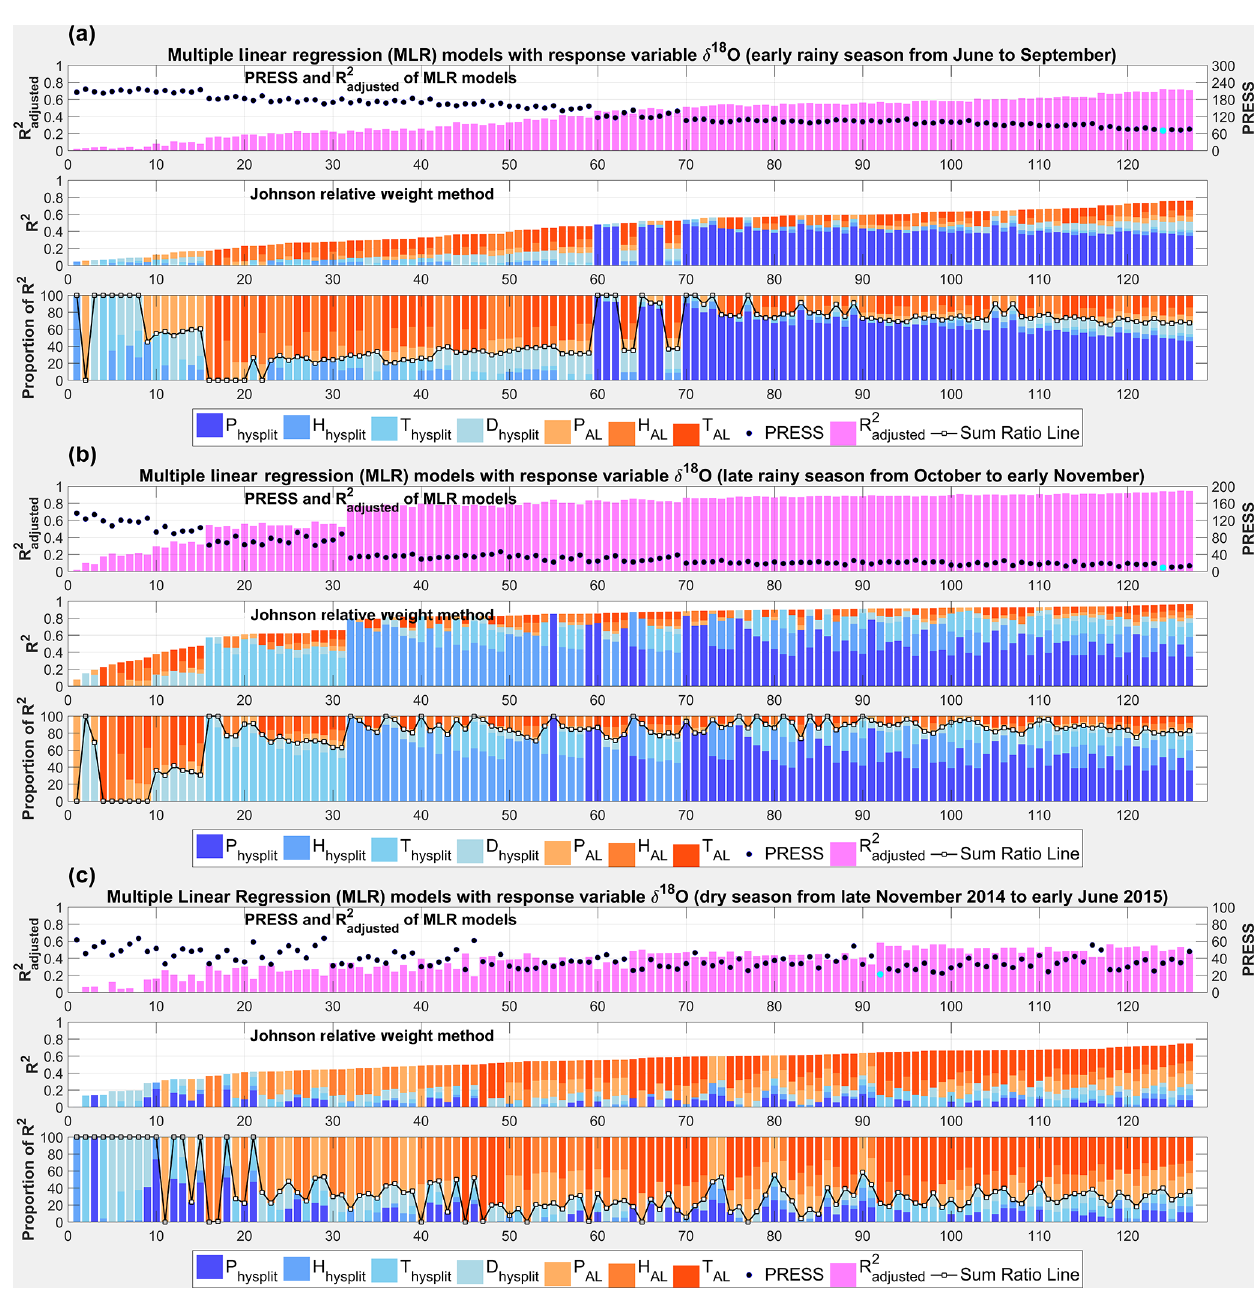
Figure 13. MLR with response variable δ 18 O and relative importance analysis applied for all possible subsets (127 MLR models) for different seasons: (a) early monsoon from June to September, (b) late monsoon from October to mid-November, and (c) the dry season from mid-November to